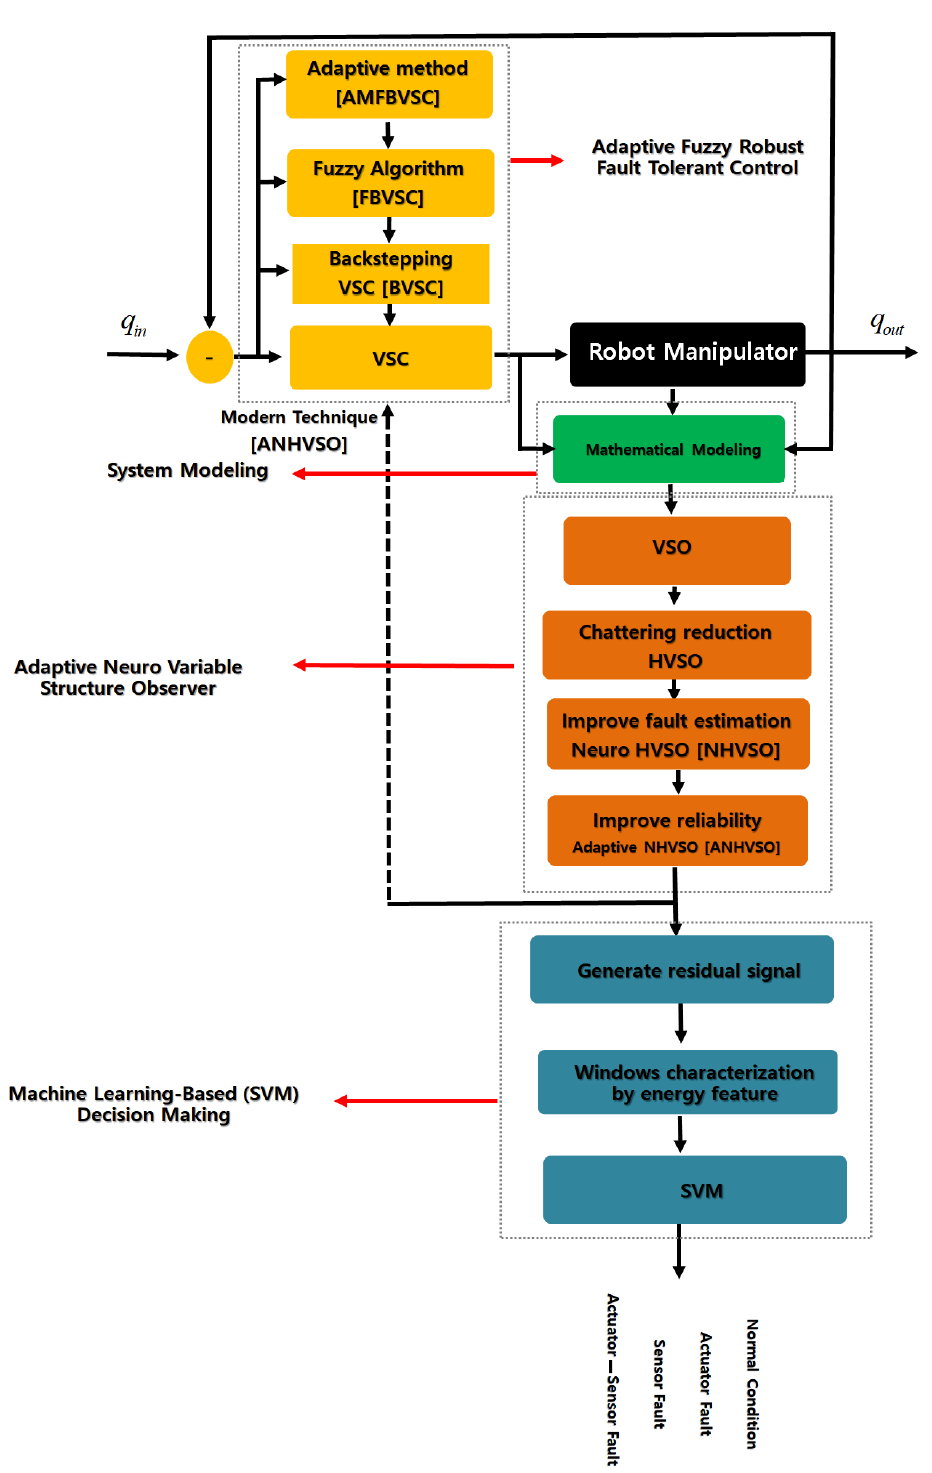
Figure 1. Block diagram of the Support Vector Machine (SVM)-based adaptive neuro variable structure observer fault diagnosis and fault-tolerant control of robot manipulator.